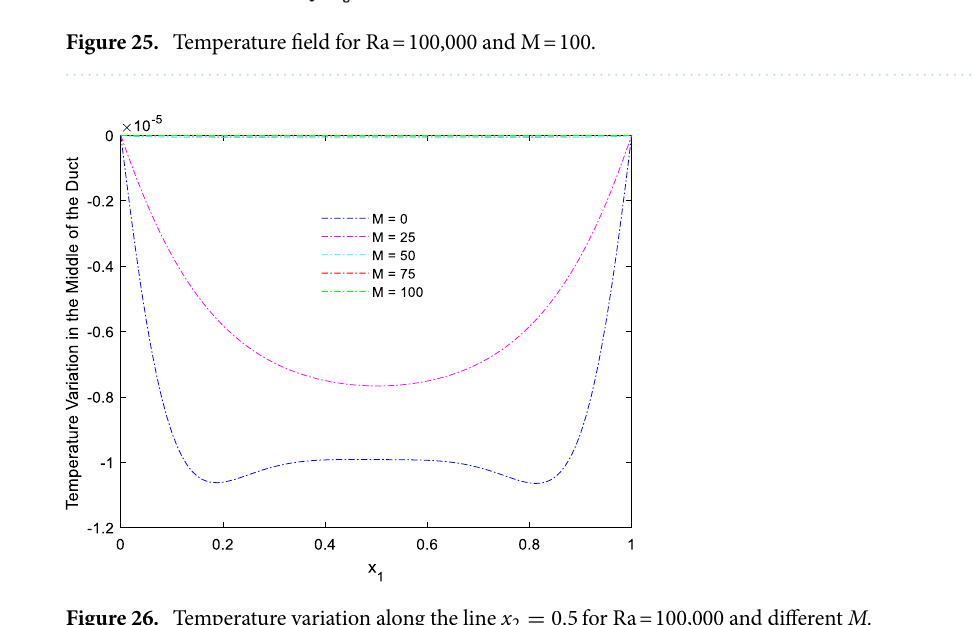
Figure 26. Temperature variation along the line x 2 = 0.5 for Ra = 100,000 and different